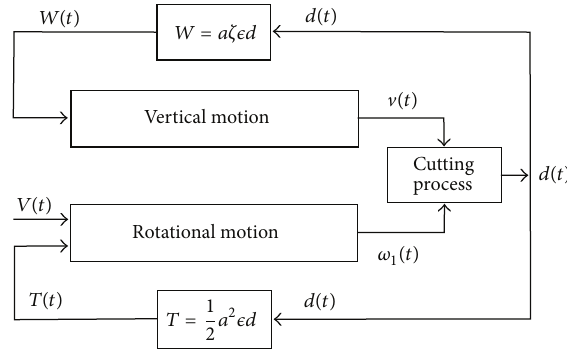
Figure 4: The block diagram of the drilling